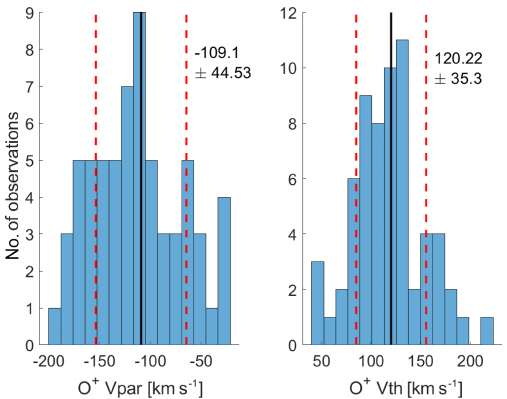
Figure 2. Cluster SC4 observations: parallel and thermal compo- nents of the O + velocity on 11 June 2001 between 01:24 and 01:29UT. The solid black line represents the mean and the dashed red lines show the standard